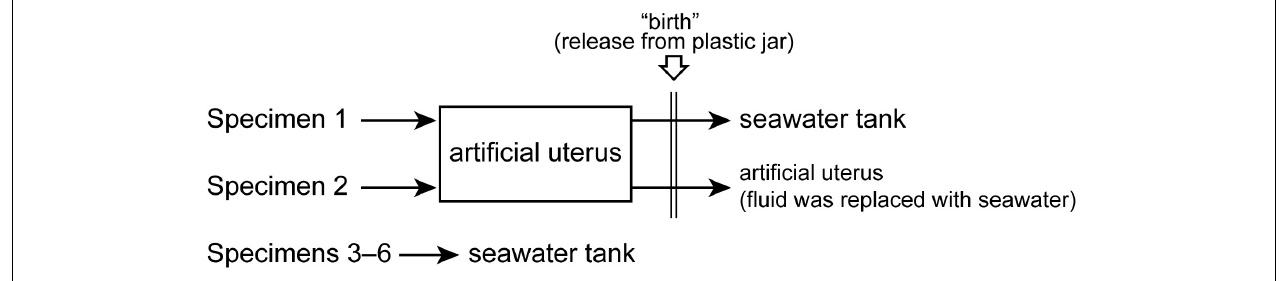
FIGURE 2 | An overview of the incubation experiment using lantern shark embryos.